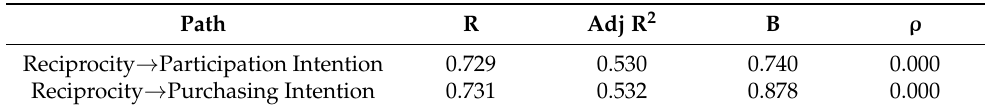
Table 2. Regression